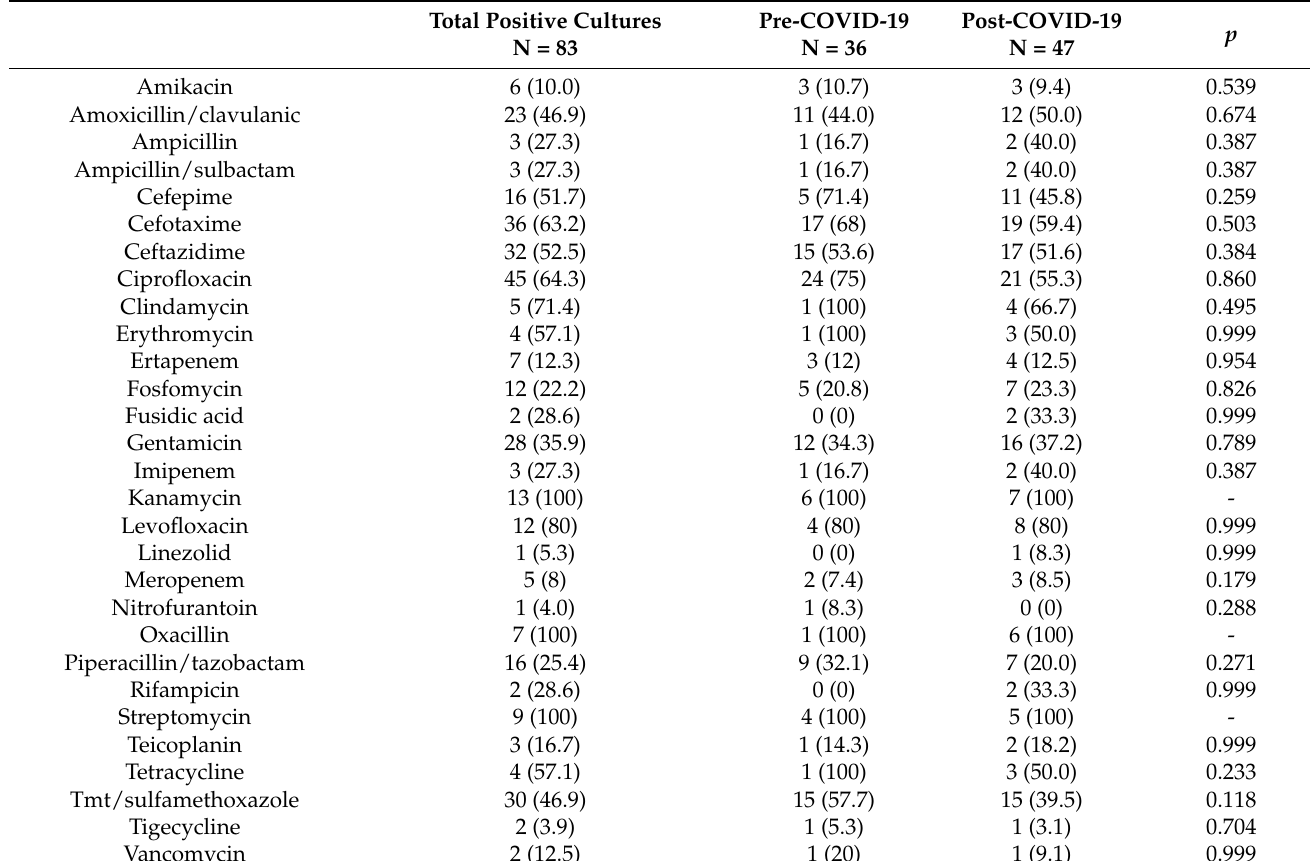
Table 3. Number and percentage of resistance reported for each antibiotic. The percentage is referred to the total number of antibiograms including the